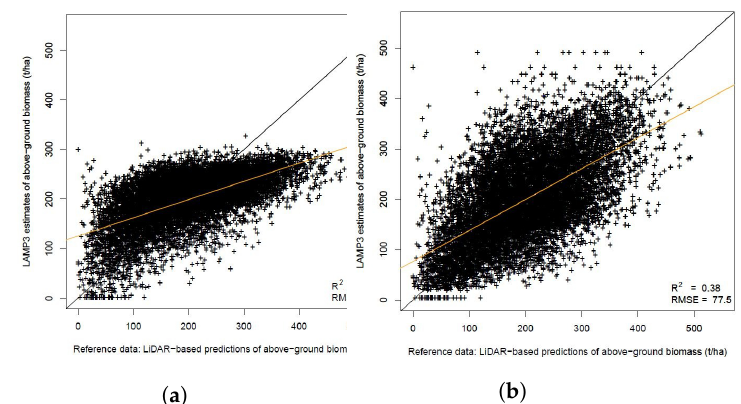
Figure 5. Above-ground-biomass estimated with LAMP3 method against the LiDAR-based predictions (reference), for the locations of 1-hectare sized surrogate plots (see Section 2.6.3). Regression trend line of the linear model in orange, optimal trend line in black. ( a ) Results before histogram matching; ( b ) Results after histogram